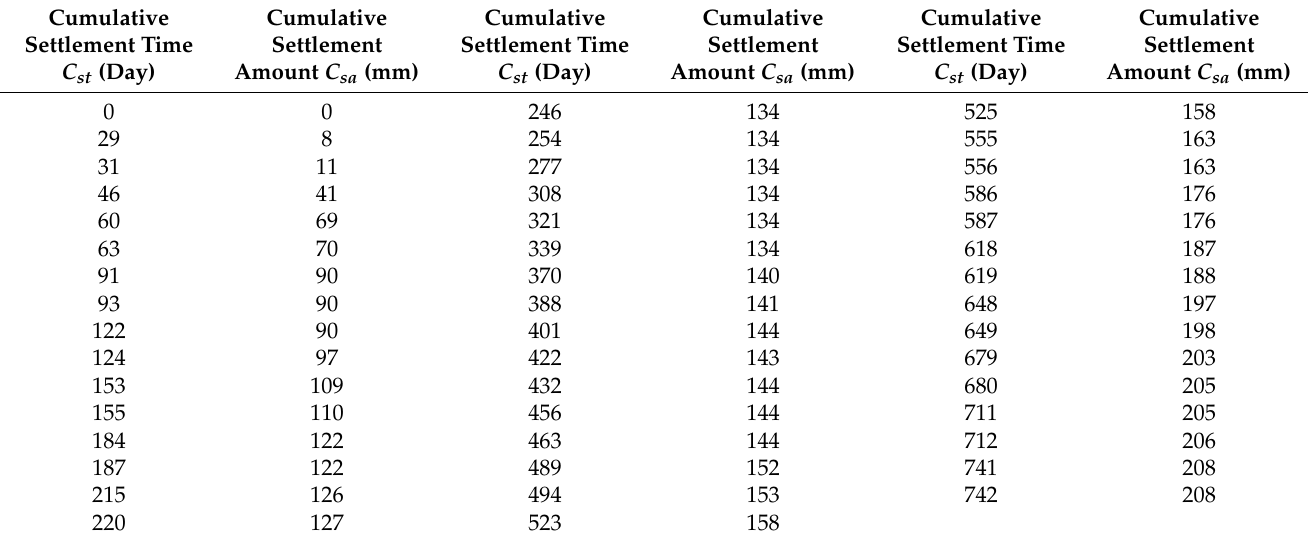
Table 1. Monitoring data of soft soil